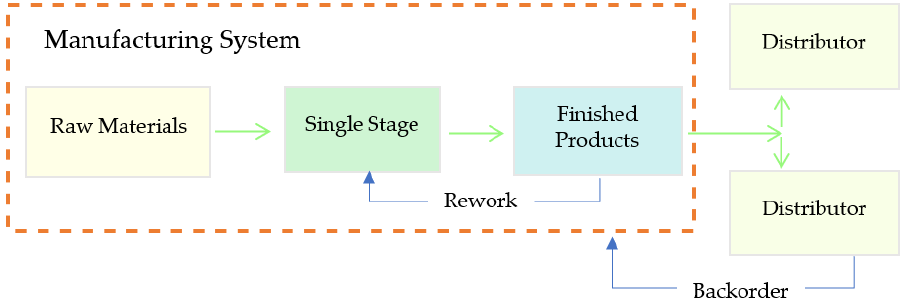
Figure 1. Inventory flow in an imperfect production setup.